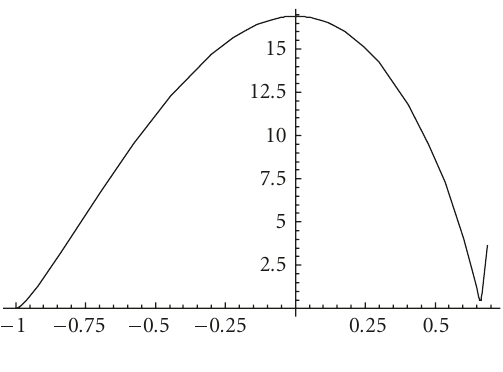
Figure 2.1. ( ξ (cid:8) 0 . 6616, ρ 0 (cid:8) − 0 .